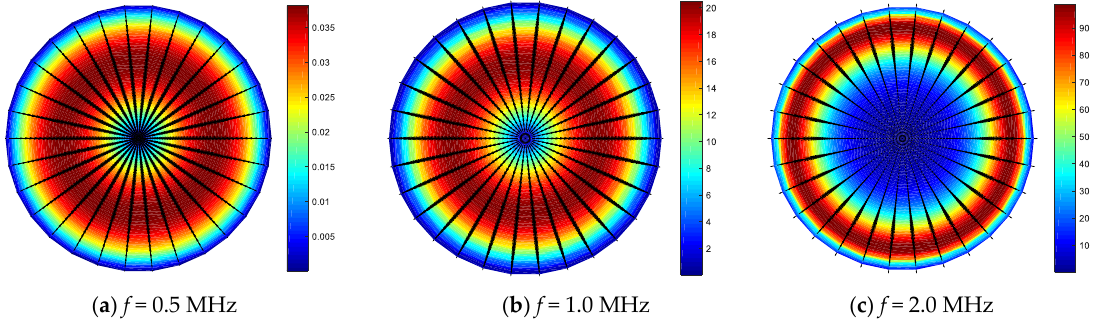
Figure 7 . L d (0,1) Poynting vector at each frequency.